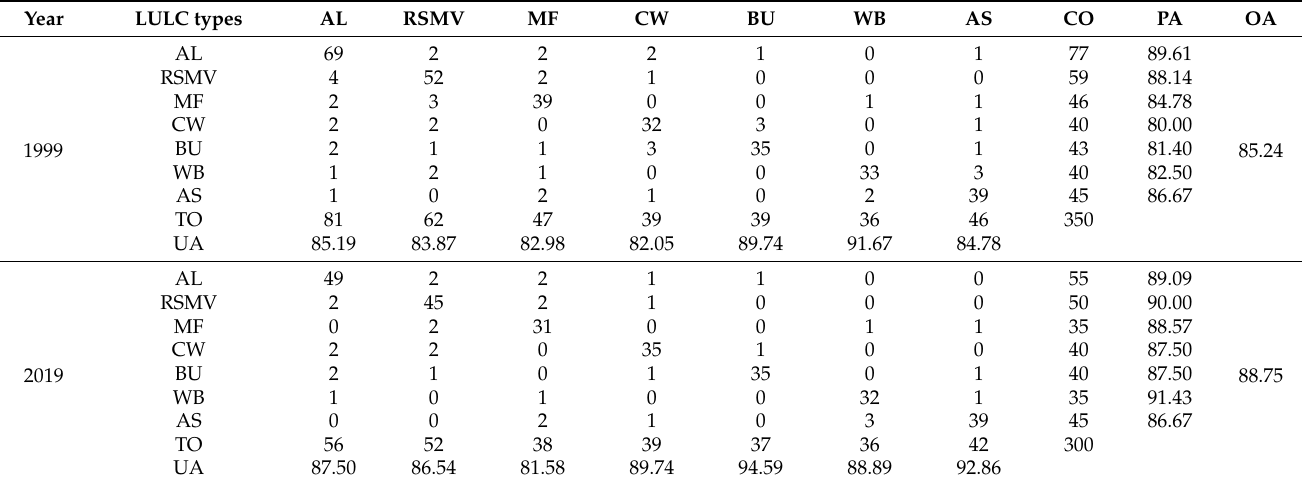
Table 2. Confusion matrix for accuracy assessment of the LULC